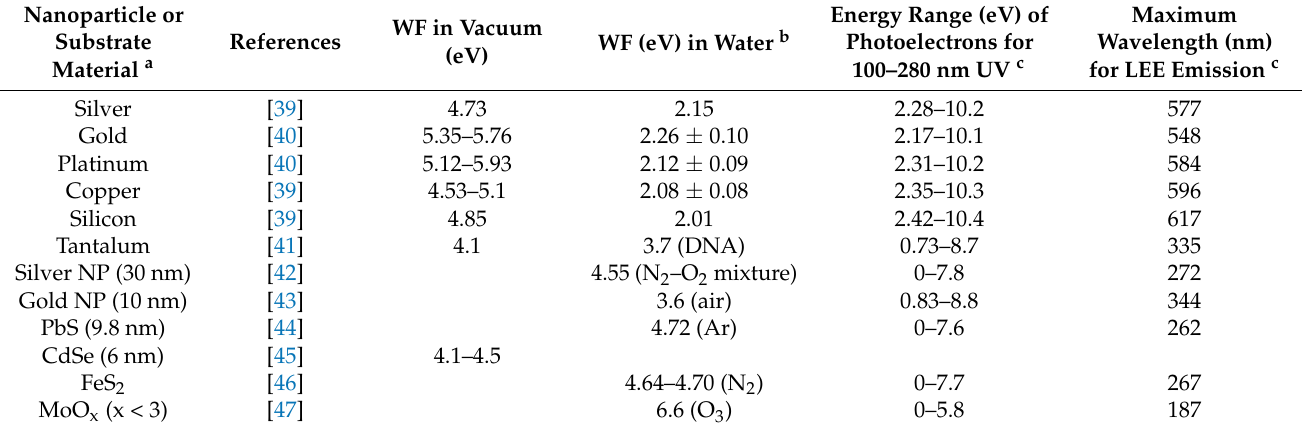
Table 1. Work functions (WFs) for different substrates and nanoparticles in vacuum, specific gaseous environments, and water. The WF for Ta covered with bacterial DNA is also included. In the last two columns, the energy range of photoelectrons emitted by 100–280 nm UV radiation and the maximum wavelengths to produce a 0 eV electron in the corresponding environment are given for each substrate or nanoparticle,